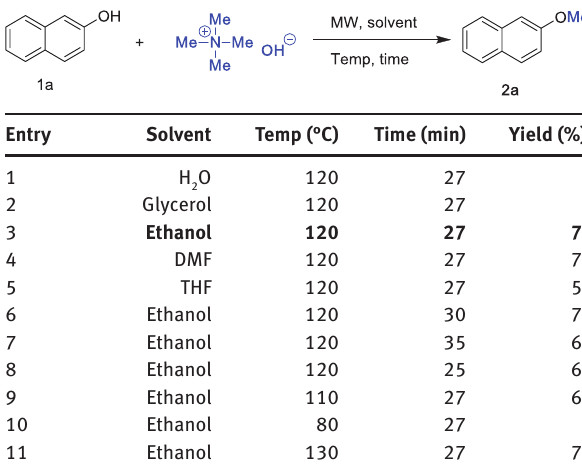
Table 1: Optimization of reaction condition.